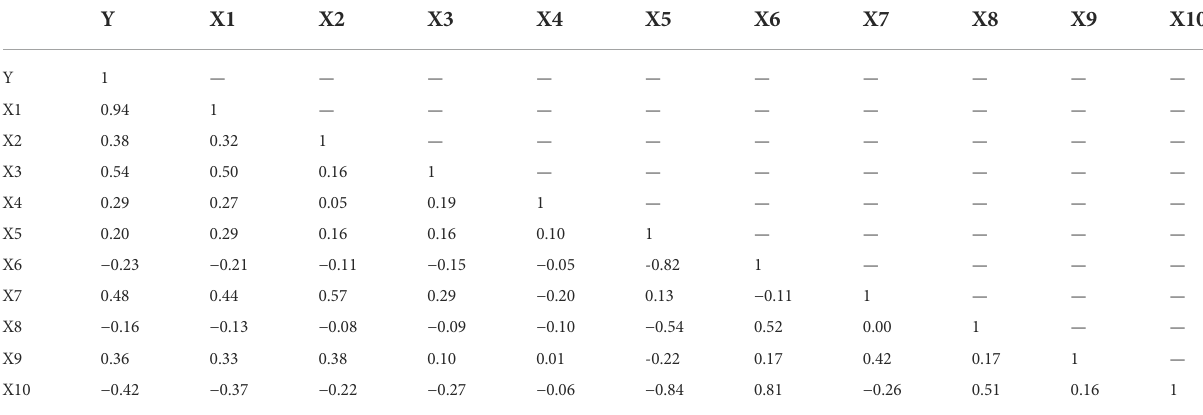
TABLE 3 Pair correlation coef fi cients.